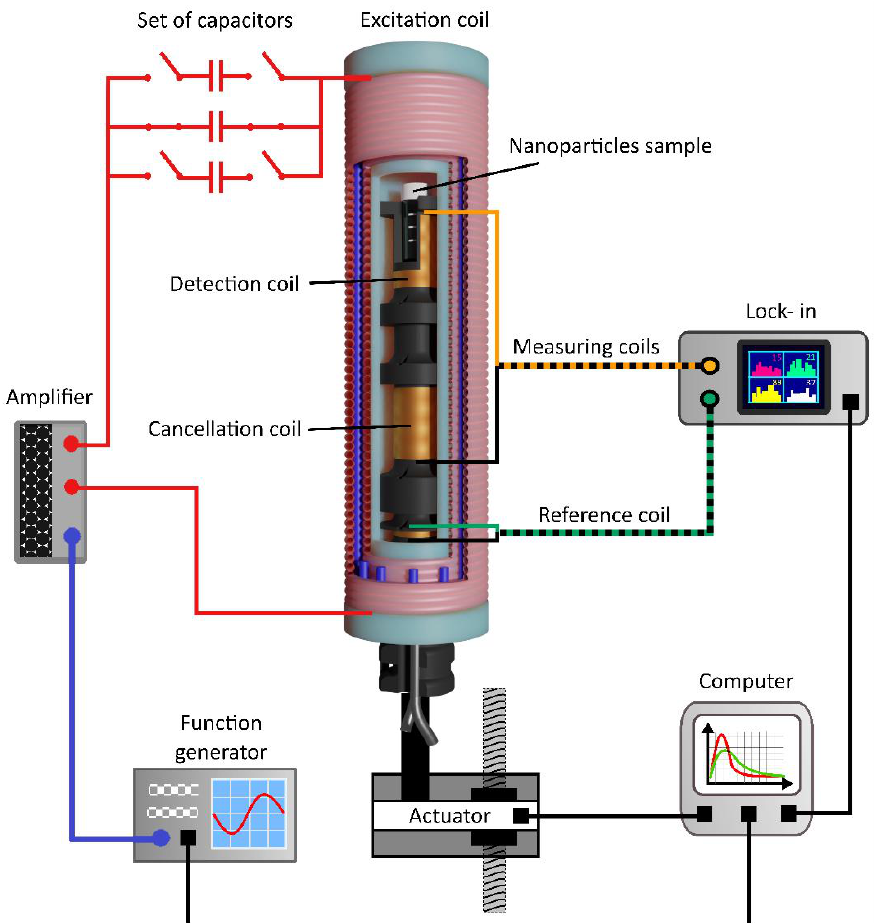
Figure 3. Schematic diagram of the measurement system with detection probe for AC magnetometry. The excitation module consists of the function generator, amplifier, set of different capacitors, and excitation coil. A detection probe comprises two separately wound coils and a reference coil placed on 3D printed carcass. The actuator controls the position of the probe. The lock-in amplifier detects the change in amplitude and phase of the magnetization signal.